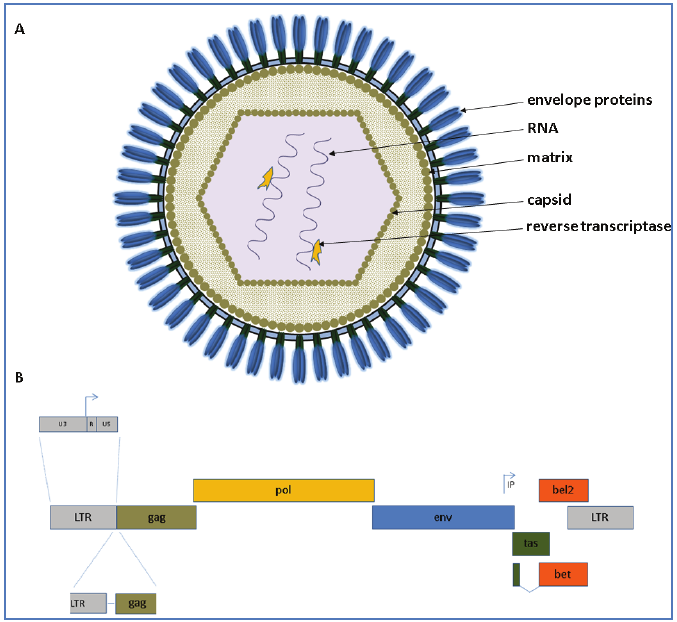
Figure 1. ( A ) Schematic presentation of a foamy virus (FV) virion is shown at the top. The appearance of the virion is based on current knowledge and observations of Wilk and co-workers who analyzed PFV and feline FV (FFV) capsids by cryo electron microscopy (cEM), paired with surface plasmogen resonance (SPR) analyses [17]; ( B ) The genomic organization of an animal FV at the DNA level is shown below (from 5' to 3'). The scheme is drawn proportionally to the original length of each gene. The canonical gag , pol and env